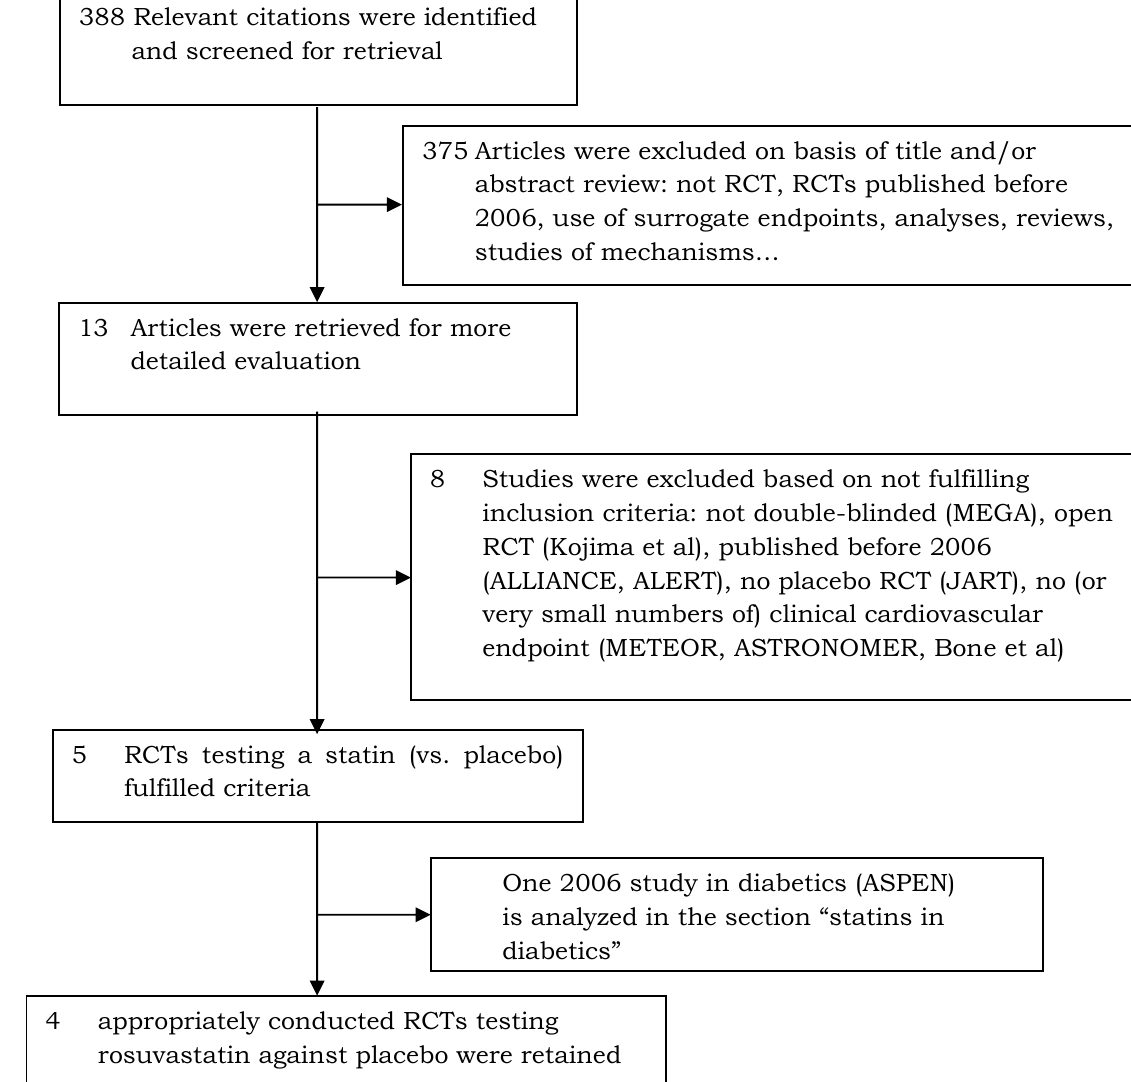
Figure 1. Flow diagram of selection of statin RCTs published after